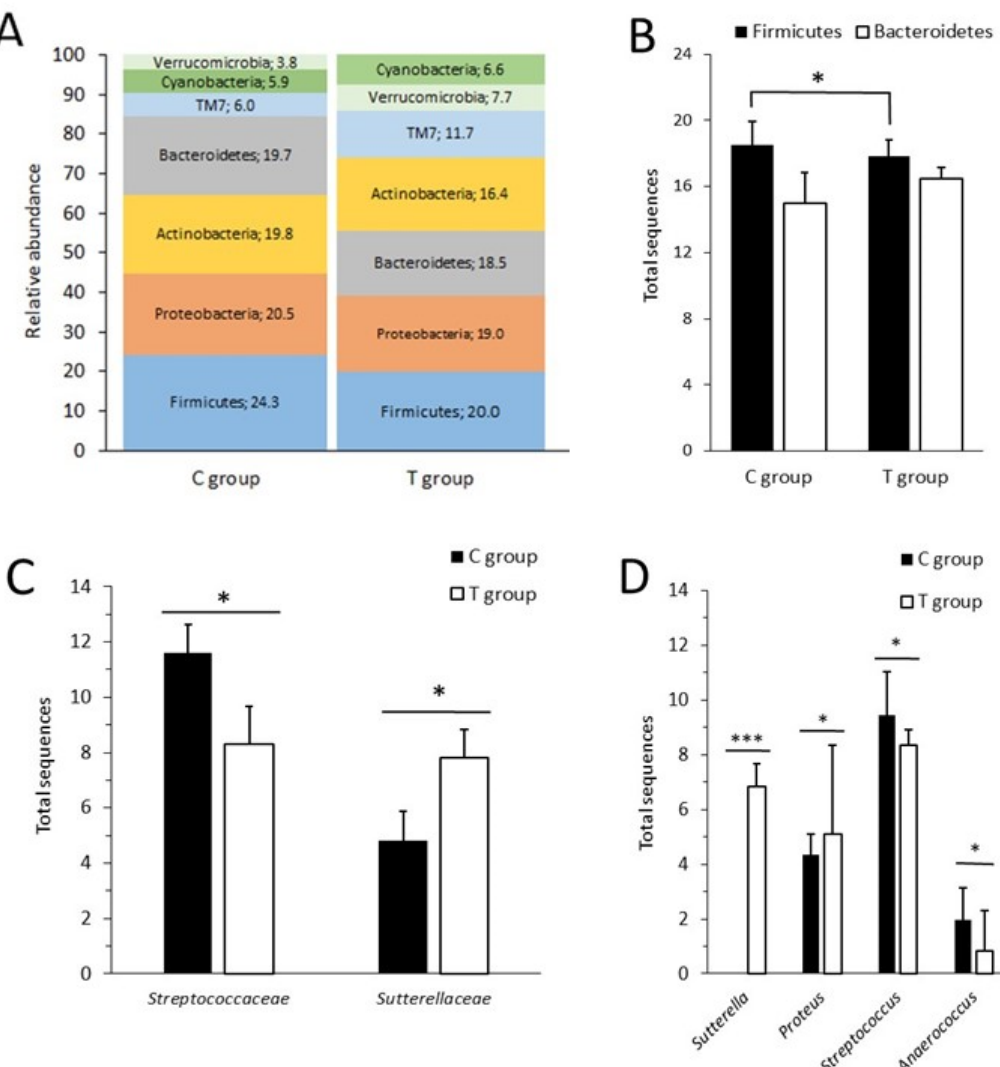
Figure 6. Fecal microbiota composition at phylum, family and genus level. ( A ) Relative abundance of phyla present in fecal samples in C and T groups. ( B ) Contributions of Firmicutes and Bacteroidetes. The abundance of Firmicutes was statistically significant higher in the C group than in the T group ( p = 0.017) however no statistically significant di ff erences were found in Firmicutes to Bacteroidetes ratio; ( n = 3 in C group and n = 3 in T group). ( C ) Fecal microbiota composition at family level. Streptococcaceae contribution was significantly higher in the control rats than in the treated ones while Sutterellaceae was enriched in the treated animals; ( n = 3 in C group and n = 3 in T group). ( D ) Widespread e ff ect of the administration of the FFP on bacterial genera. Representation of statistically significant genera between groups at six months. Sutterella and Proteus were found enriched in the T group whereas Anaerococcus and Streptococcus were more prominent in the C group; ( n = 3 in C group and n = 3 in T group). * p < 0.05, *** p < 0.01.